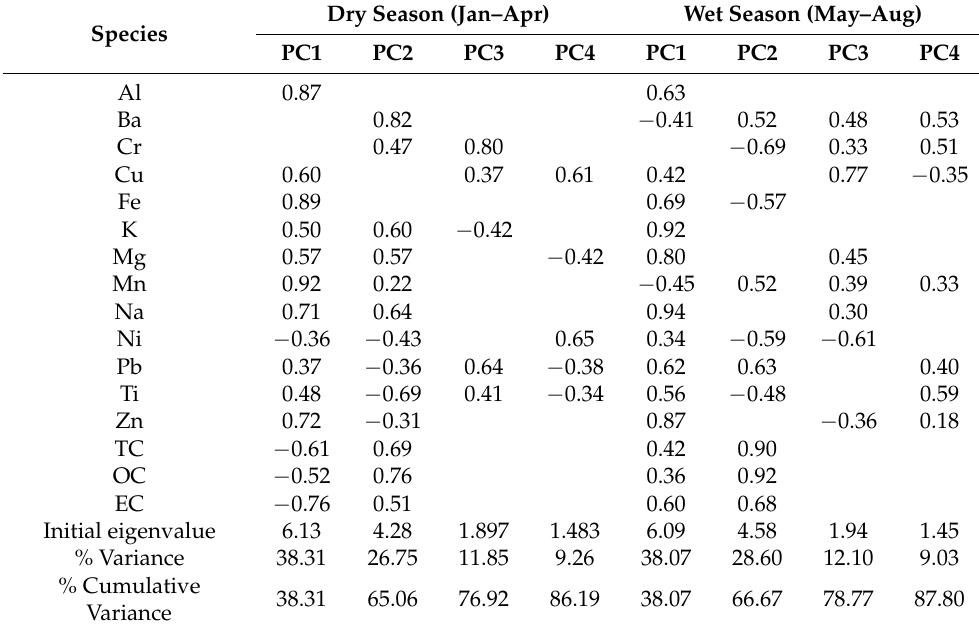
Table 5. Principal components in the PM 0.1 fraction by